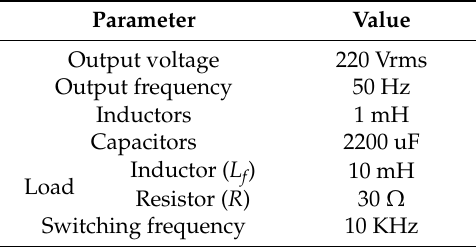
Table 3. Parameters for the three-phase CHB-qSBI inverter.